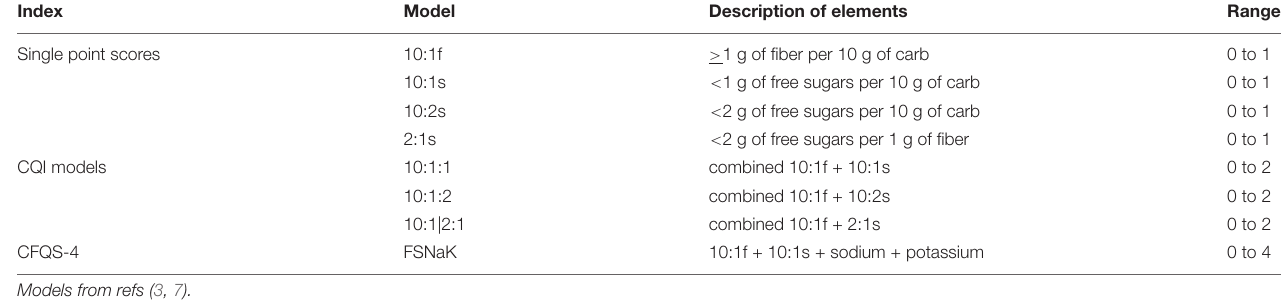
TABLE 2 | Selected indices of carbohydrate quality. Index Model Description of